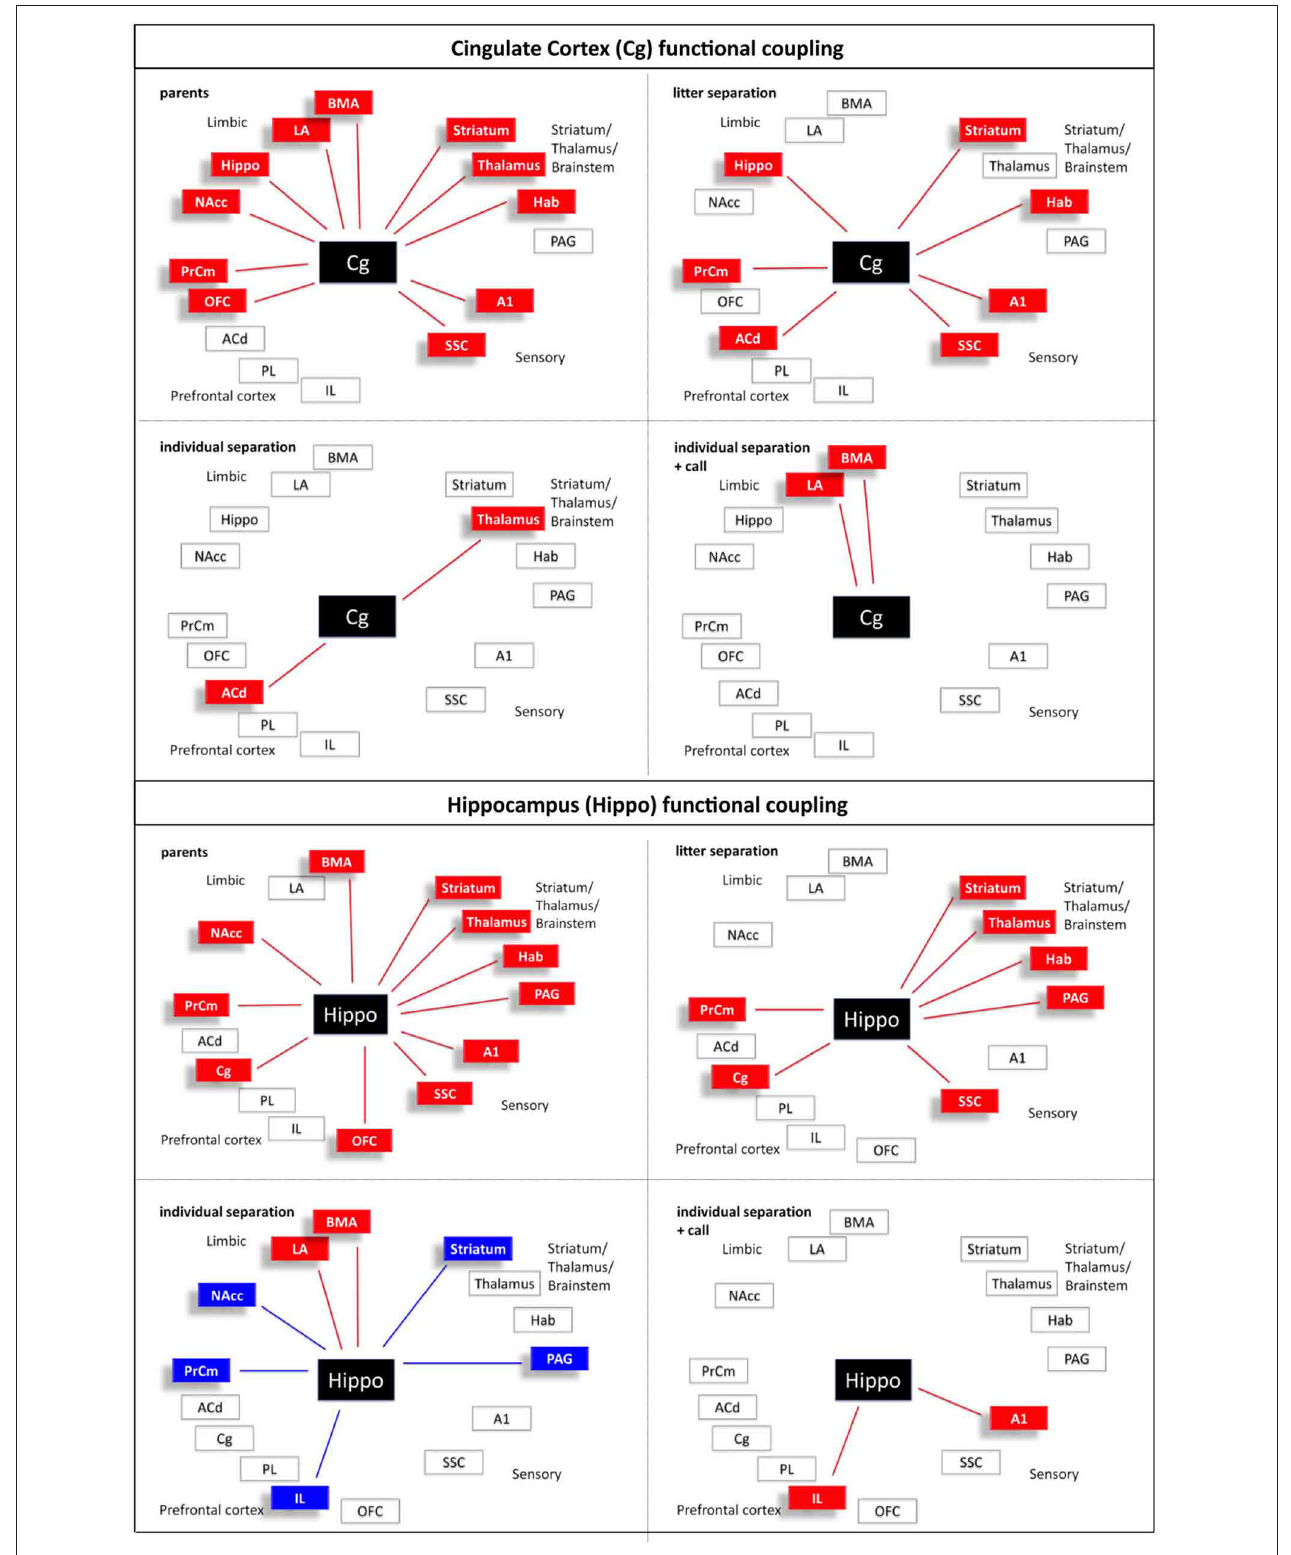
FIGURE 8 | Interregional functional coupling of the cingulate cortex (Cg) and hippocampus (Hippo) under different stress conditions. Red color indicates positive, blue color indicates negative correlations ( p < 0 . 05).